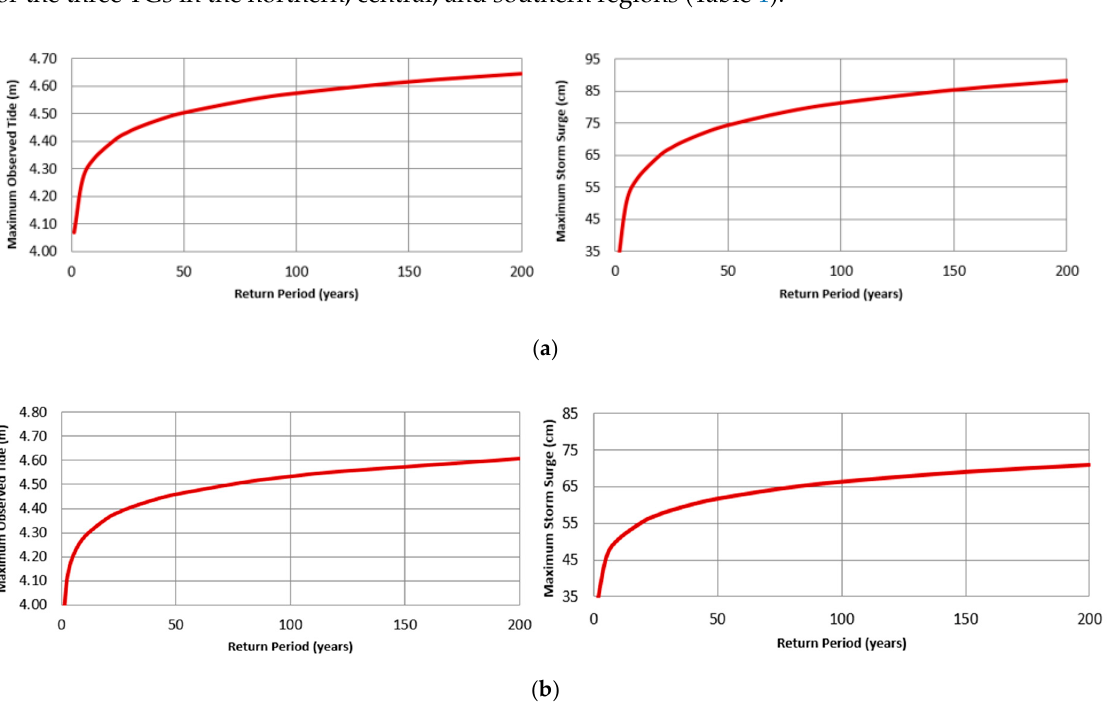
Figure 2. Location of the five tide gauges (TGs) used in the study: Leixões, Cascais, Sines, and Lagos for the tide modeling and Viana do Castelo for storm surge analysis in the northern region.